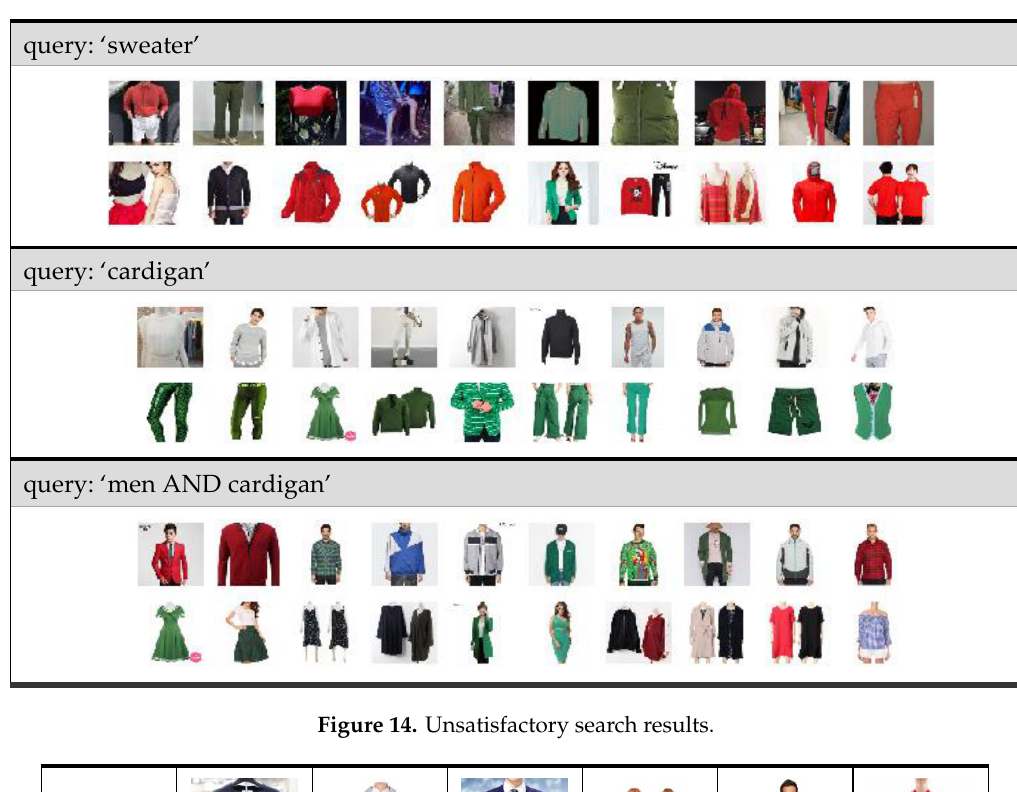
Figure 14. Unsatisfactory search results.